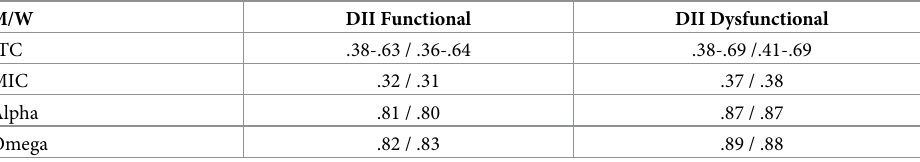
Table 4. Internal consistency of the